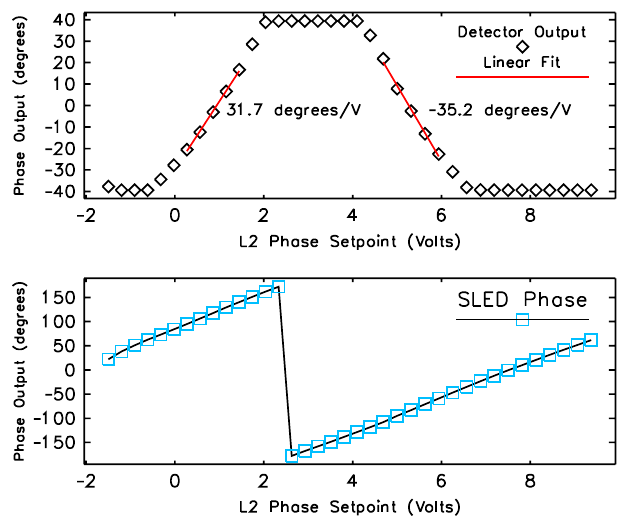
FIG. 5. (Color) L2 phase detector output compared to L2 SLED phase output vs L2 phase setpoint. L2 SLED phase is measured relative to the S-Band source. Linear fits to the phase detector output in the nonsaturated part of the data along with the fit slope are displayed.